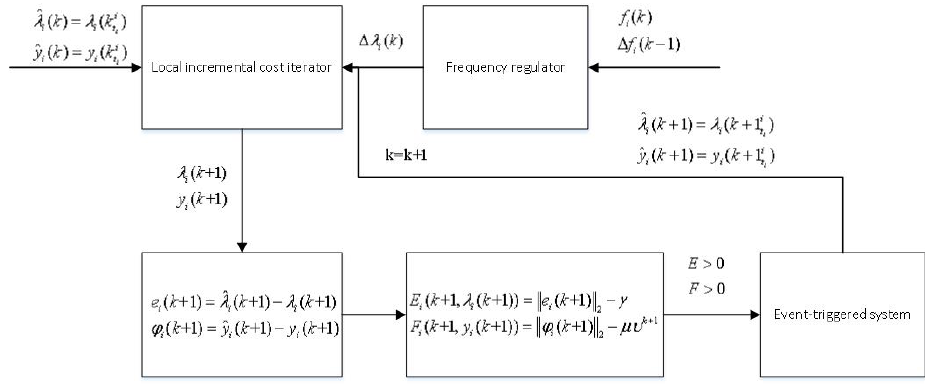
Figure 1. Algorithm flow